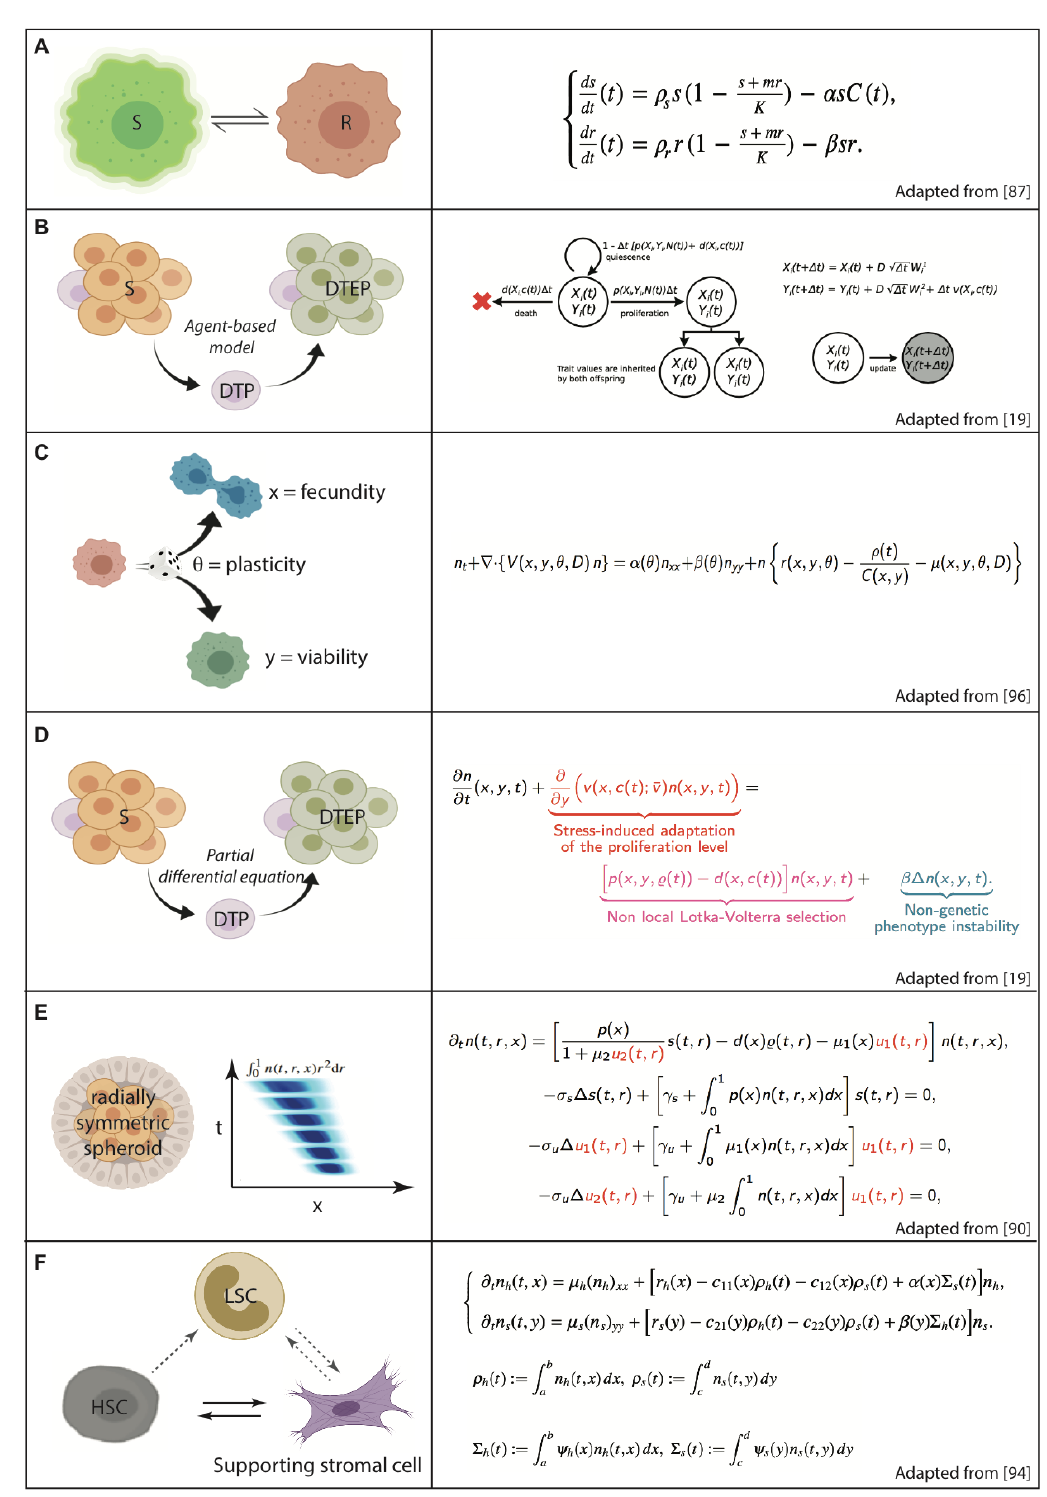
Figure 2. Referenced mathematical models of cell populations take cell plasticity into account by making use of ordinary differential equations (A), agent-based models (B) and phenotype-structured partial differential equations (C–F). Here, we present only the dynamics, not the initial or the boundary conditions, of the models. These models are chosen to be simple on purpose since they are all meant to provide a theoretical framework for therapeutic control and its optimisation. In particular, we do not present large systems of ordinary differential equations or large molecular networks, which nonetheless are referenced in the text. DTEP, Drug tolerant expanded persister; DTP, Drug tolerant persister; HSC, Hematopoetic stem cell; LSC, Leukemic stem cell; R, Resistant cell; S, Sensitive